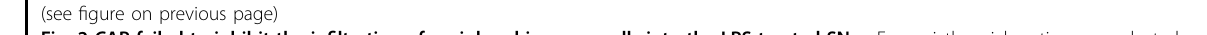
(Fig. 3g – i). Additional immunohistochemical analysis showed that CAP induced no morphological changes of CD11b + cells compared to control (vehicle) (Supple- mentary Fig. 1a). Similar to Fig. 3g – i, in CAP-treated LPS- lesioned SN, expression of IL-1 β , iNOS and COX-2 pro- tein in CD11b + cells was also observed, although we did not quantify the data (Supplementary Fig. 1b).